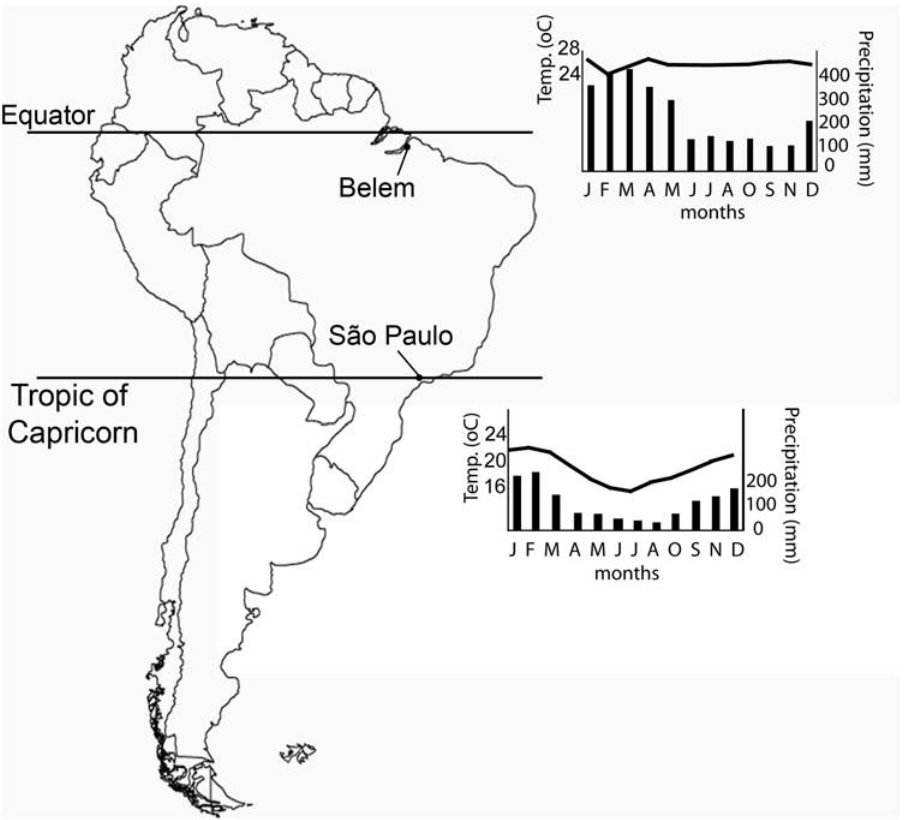
Figure 1. Map of South America, showing the location of Bele´m and Sa˜o Paulo, and key monthly climatic indicators in these cities (continuous line represents mean temperatures, and bars represent precipitations). Climatic data are averaged for the period from 1961 to 1990—as made available by the Brazilian Institute of Meteorology [26]